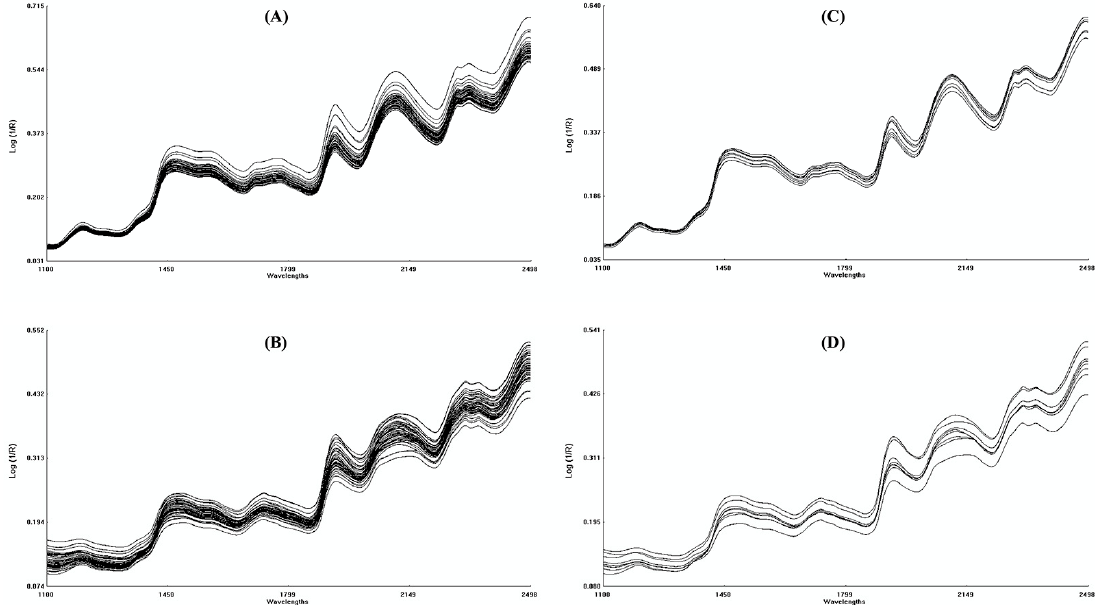
Figure 3. NIR spectra of the eight sweet potato accessions, with 129 root ( A ) and 135 shoot ( B ) samples, and 24 external set validation for both root ( C ) and shoot ( D ) samples. Wavelengths from 1100–2498.2 nm of the NIR range.